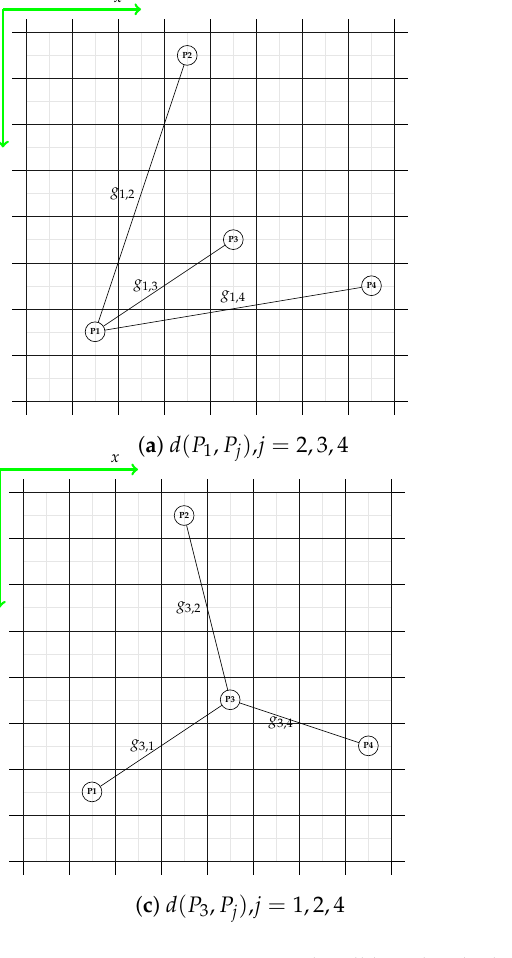
Figure 7. Total well length calculations, based on nodal point